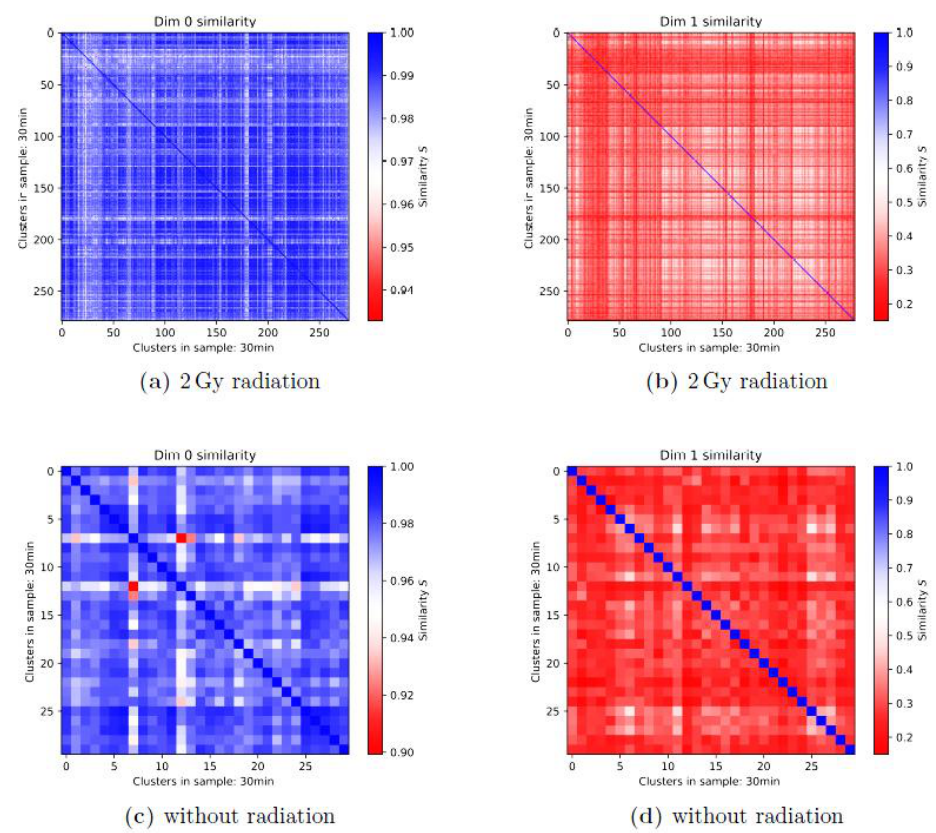
Figure 5. First-generation heatmaps of γ H2AX clusters in MCF-7 cells of ( a , b ) the irradiated samples (2 Gy) and ( c , d ) the non-irradiated control at the time point of 30 min after irradiation. ( a , c ) Heatmaps of the components; ( b , d ) heatmaps of the holes. Note the different color bars and the significantly different cluster numbers (more than 278 for the irradiated specimen vs. 30 for the non-irradiated specimen).